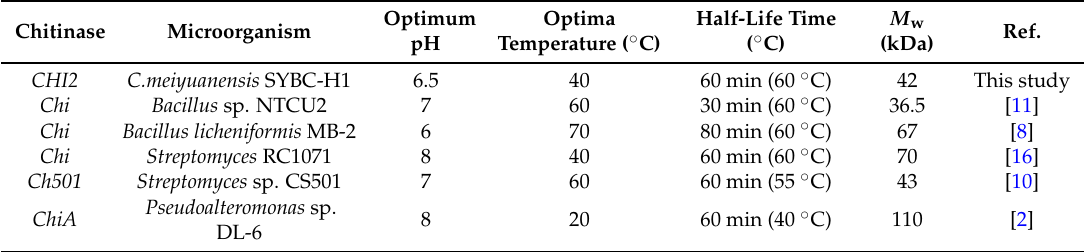
Figure 5. ( A ) Effect of temperature on the activity of chitinase from C. meiyuanensis SYBC-H1; ( B ) Effect of pH on the activity of chitinase from C. meiyuanensis SYBC-H1. Table 2. Comparison between the properties of CHI2 chitinase and those of other typical chitinases.